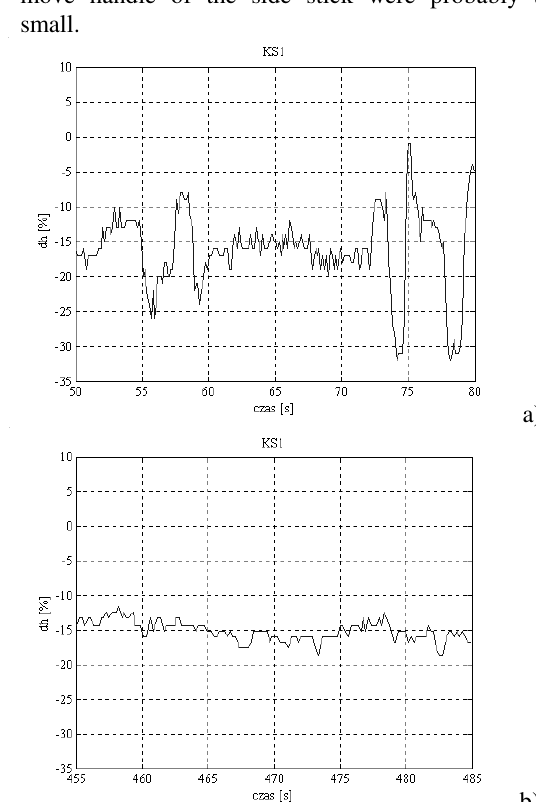
Fig 2. During a sample maneuver of altitude stabilization there were more displacements of elevator having bigger amplitude in the case of the FBW control system a) then for the original mechanical one b)